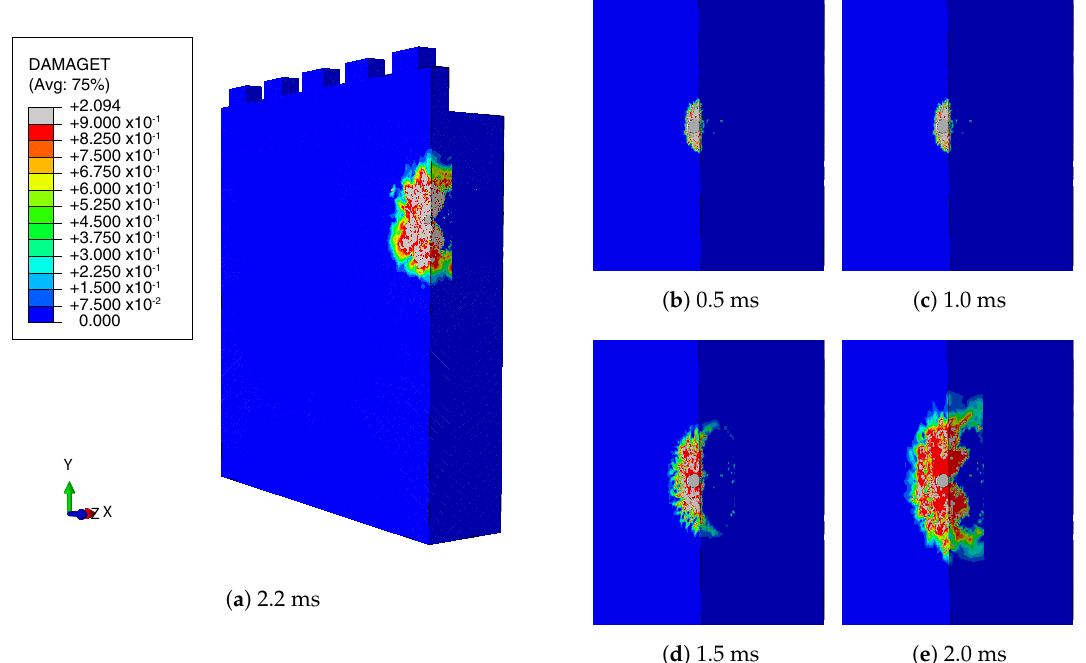
Figure 5. Maps of the tensile damage ( d t ) and zoom on the impact point at different instants of time.